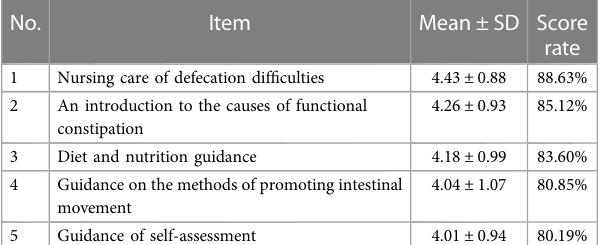
TABLE 4 The fi ve items with the highest scores. No.